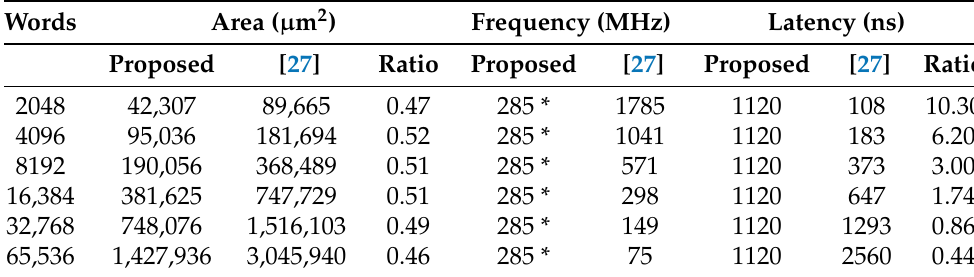
Table 2. Area and timing, word width = 64 bit.